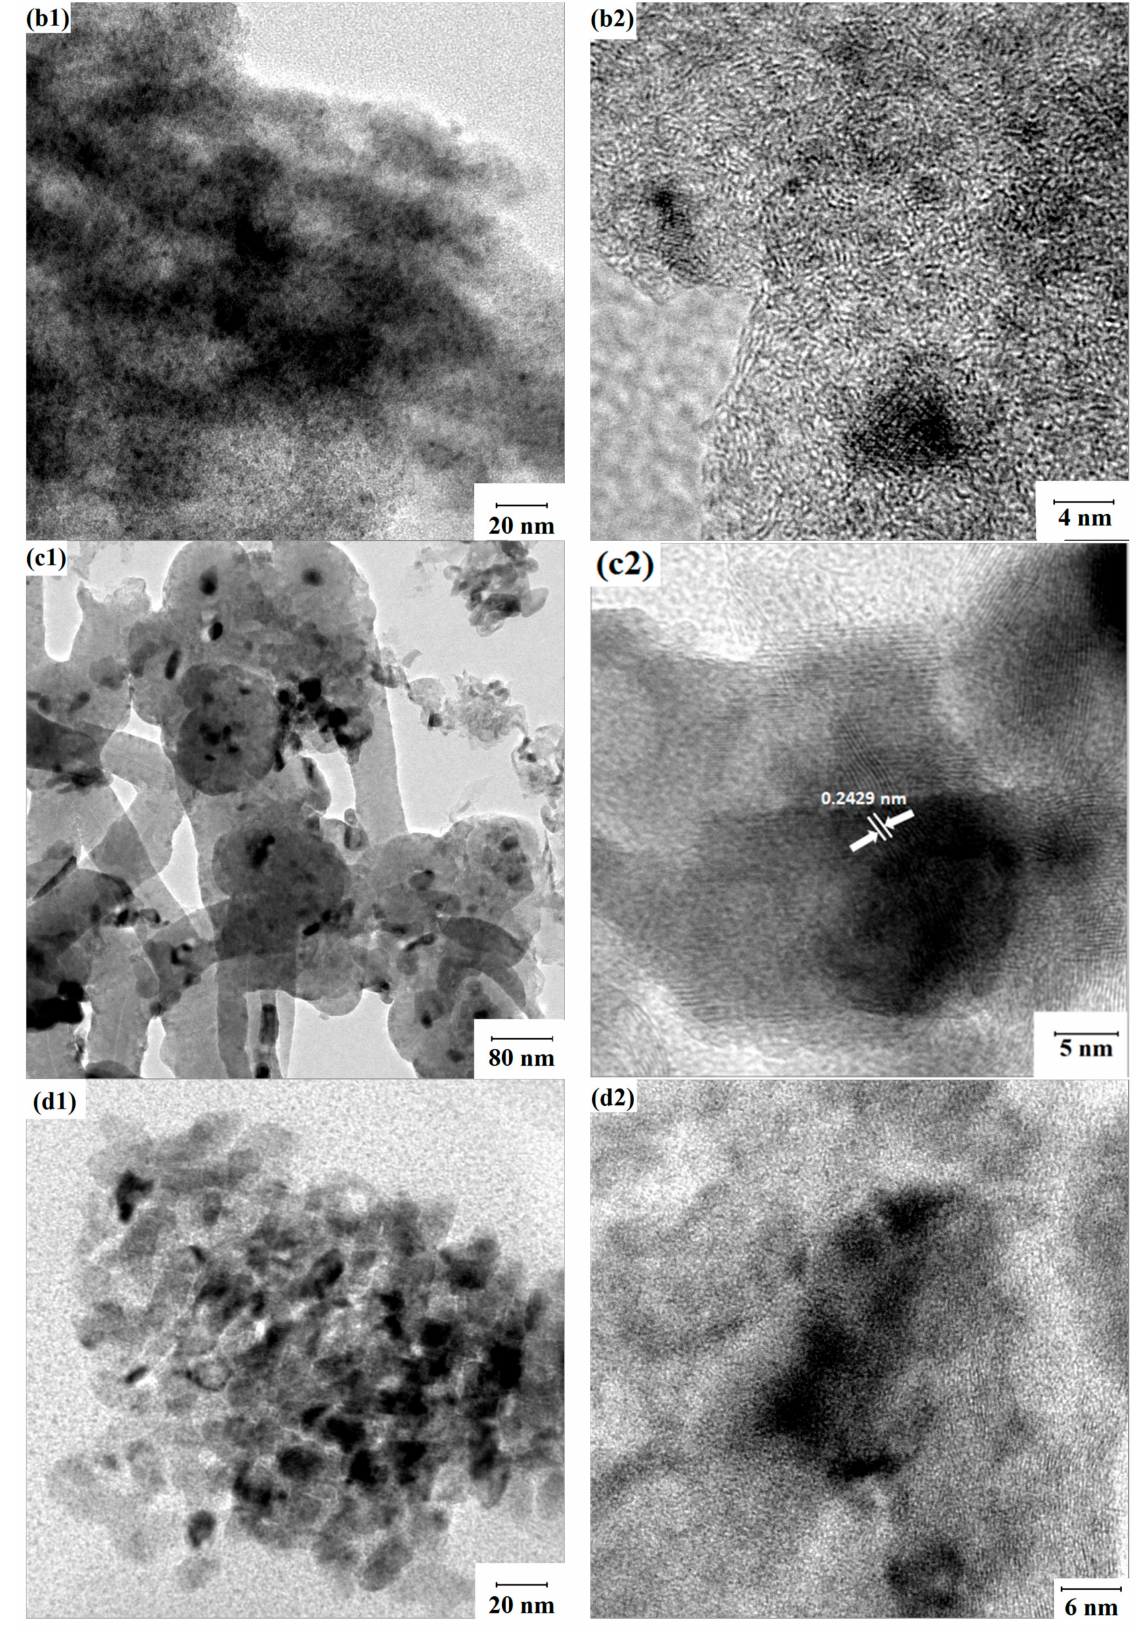
Figure 4. TEM images results ( a1 ): Co/CNT, ( a2 ): CNT, ( b1 ): Co/AC, ( b2 ): AC, ( c1 ): Co/CNF, ( c2 ): CNF, ( d1 ): Co/rGO, ( d2 ):